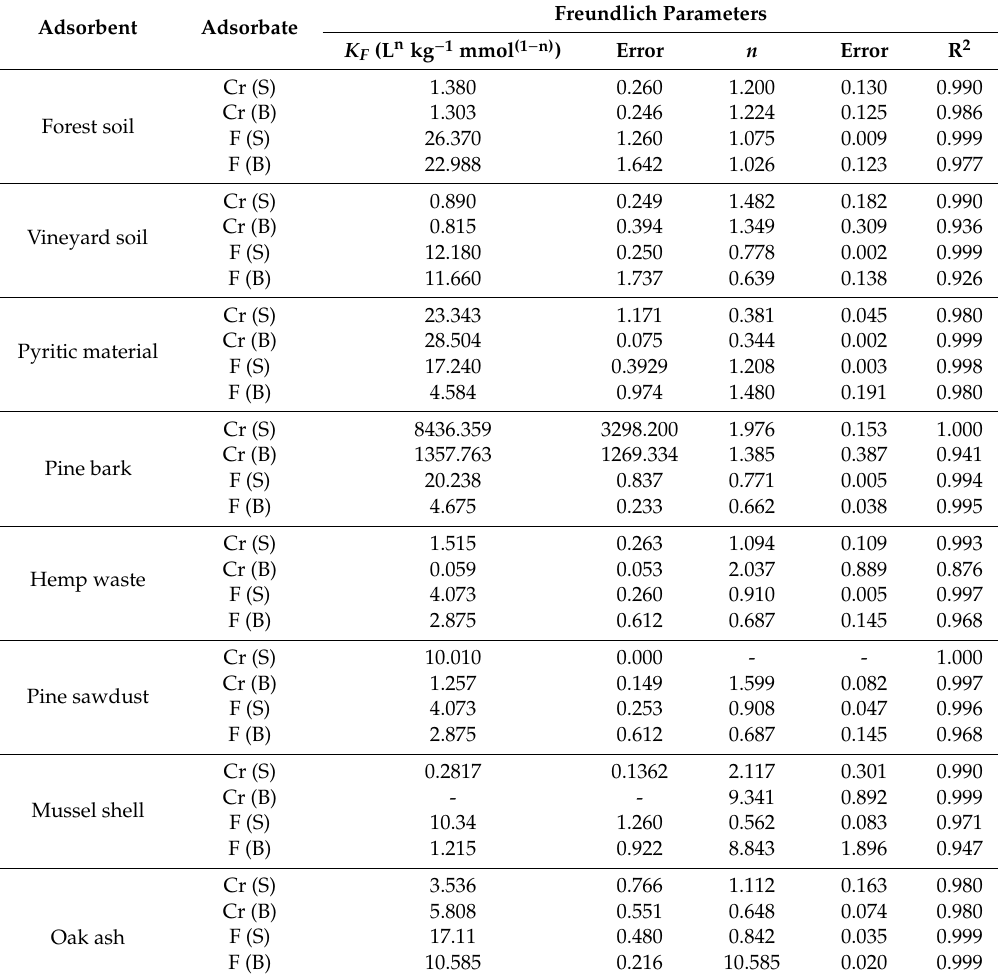
Table 2. Parameters of the Freundlich model for Cr(VI) and F − in individual simple (S) and competitive binary (B)